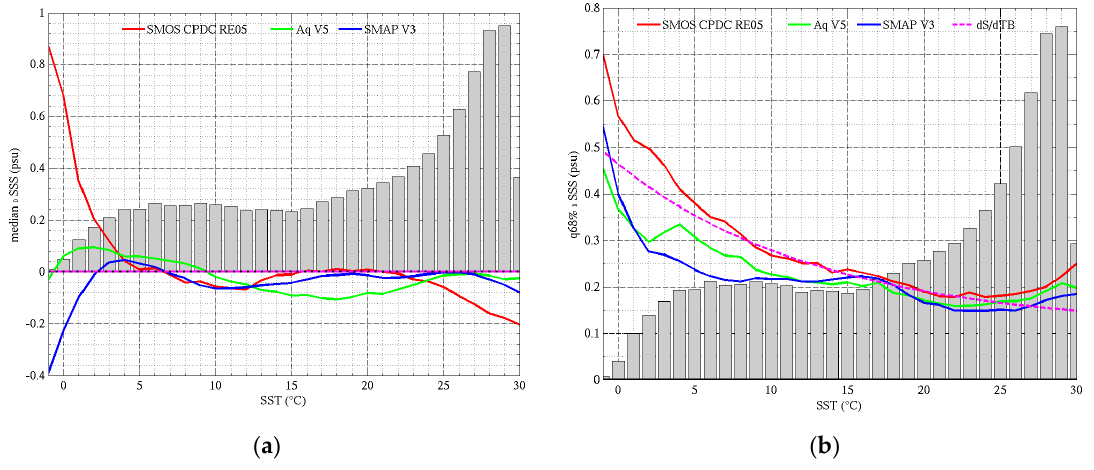
Figure 15. SSS ( a ) bias and ( b ) variable difference between satellite retrievals and in situ Argo measurements as a function of SST for SMOS CPDC RE05, and the latest Aquarius (V5) and SMAP (V3) versions. SMOS includes filtering of land contamination by removing data closer than 1,000 km from the coast. The vertical bars in the background report the statistical distribution of the samples as a function of SST. The magenta dashed curve in the right ( b ) panel reports the relative change in the inverse of the radiometric sensitivity to SSS as a function of SST, scaled to match SSS error curves at 18 °C.